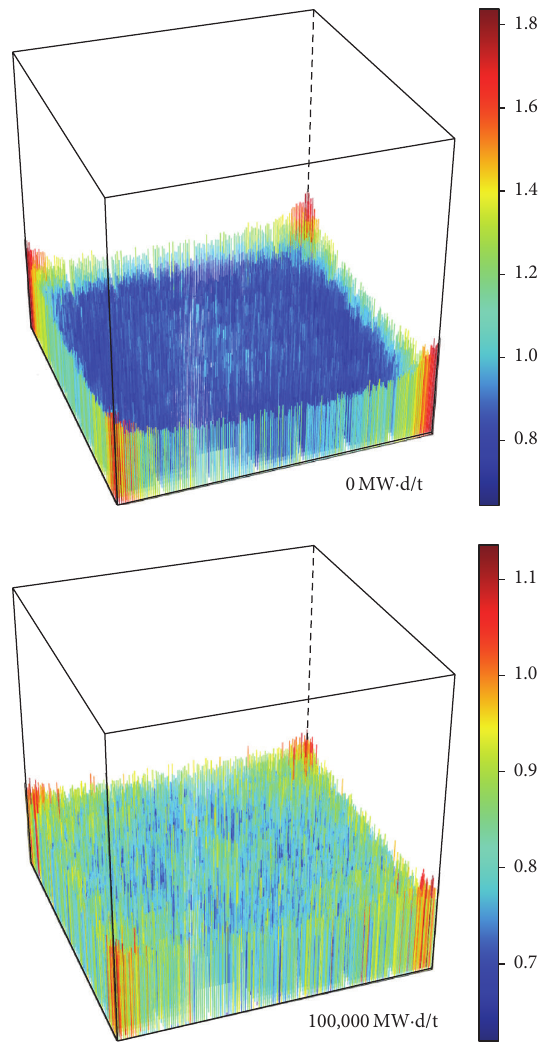
Figure 8: Uncertainty on power factors (% at 1𝜎